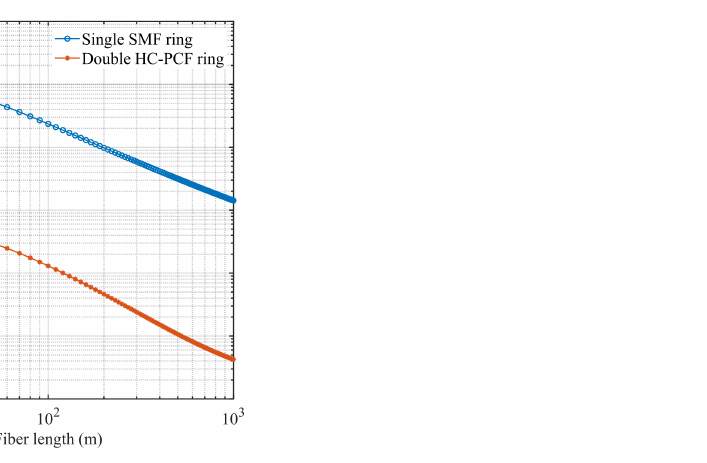
Figure 6. Comparison of angular velocity drift Ω bias induced by Kerr effect when the light source has a fixed linewidth of 50 KHz: the blue line is the drift of the conventional RFOG with a sing SMF ring resonator, and the orange line is the drift of the